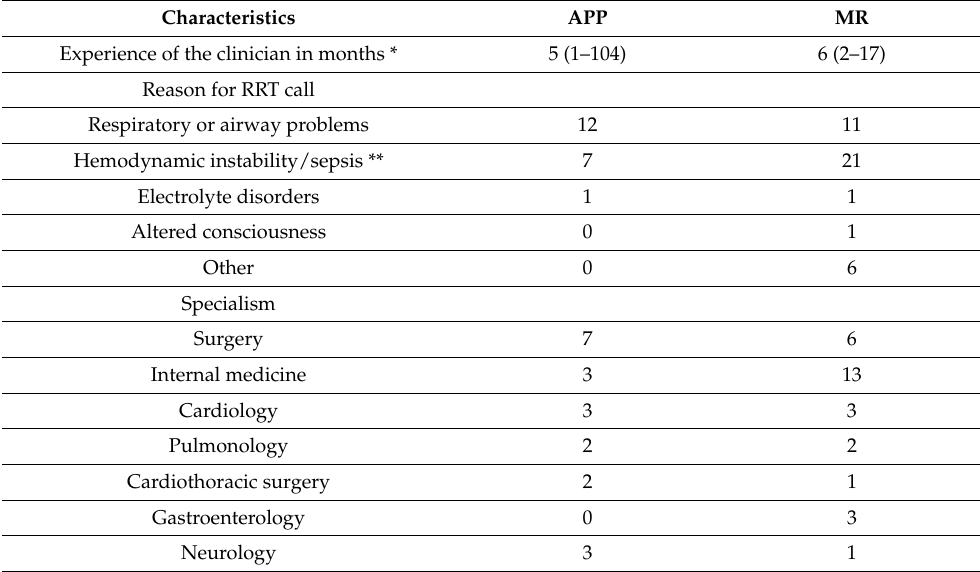
Table 1. Baseline characteristics of patients treated by either an APP or an